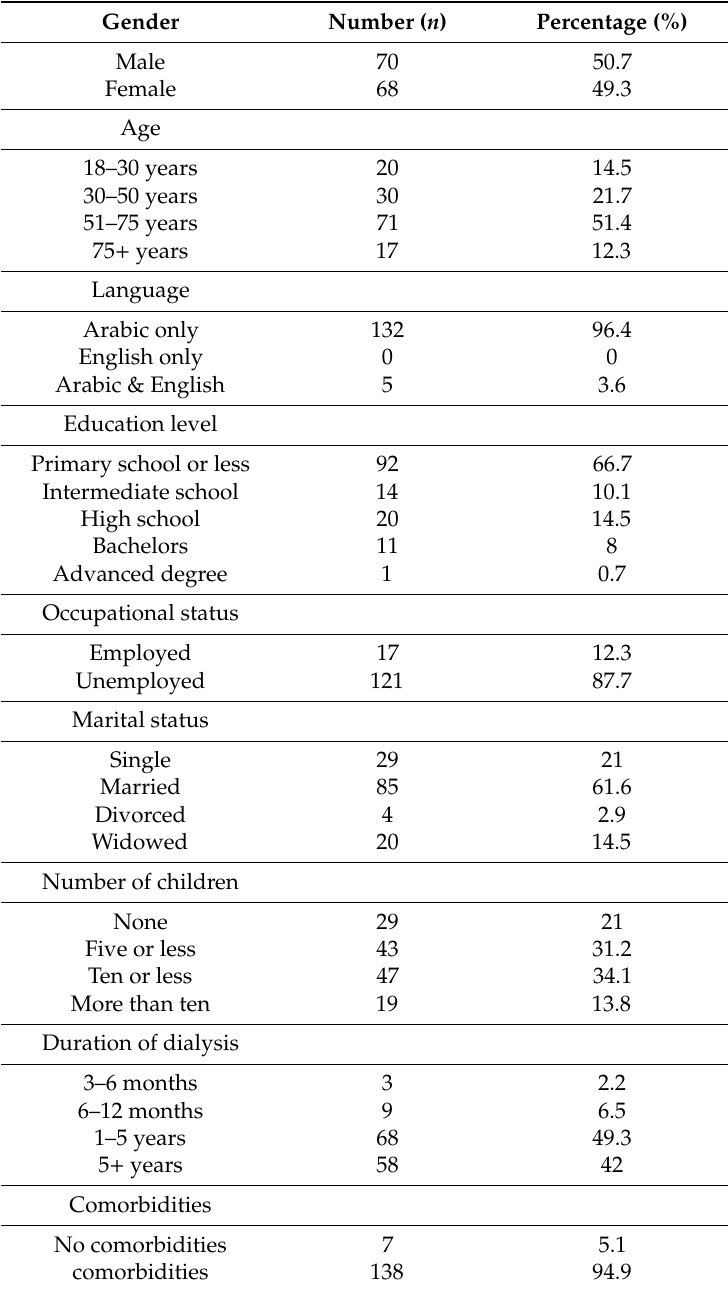
Table 1. Characteristics of hemodialysis